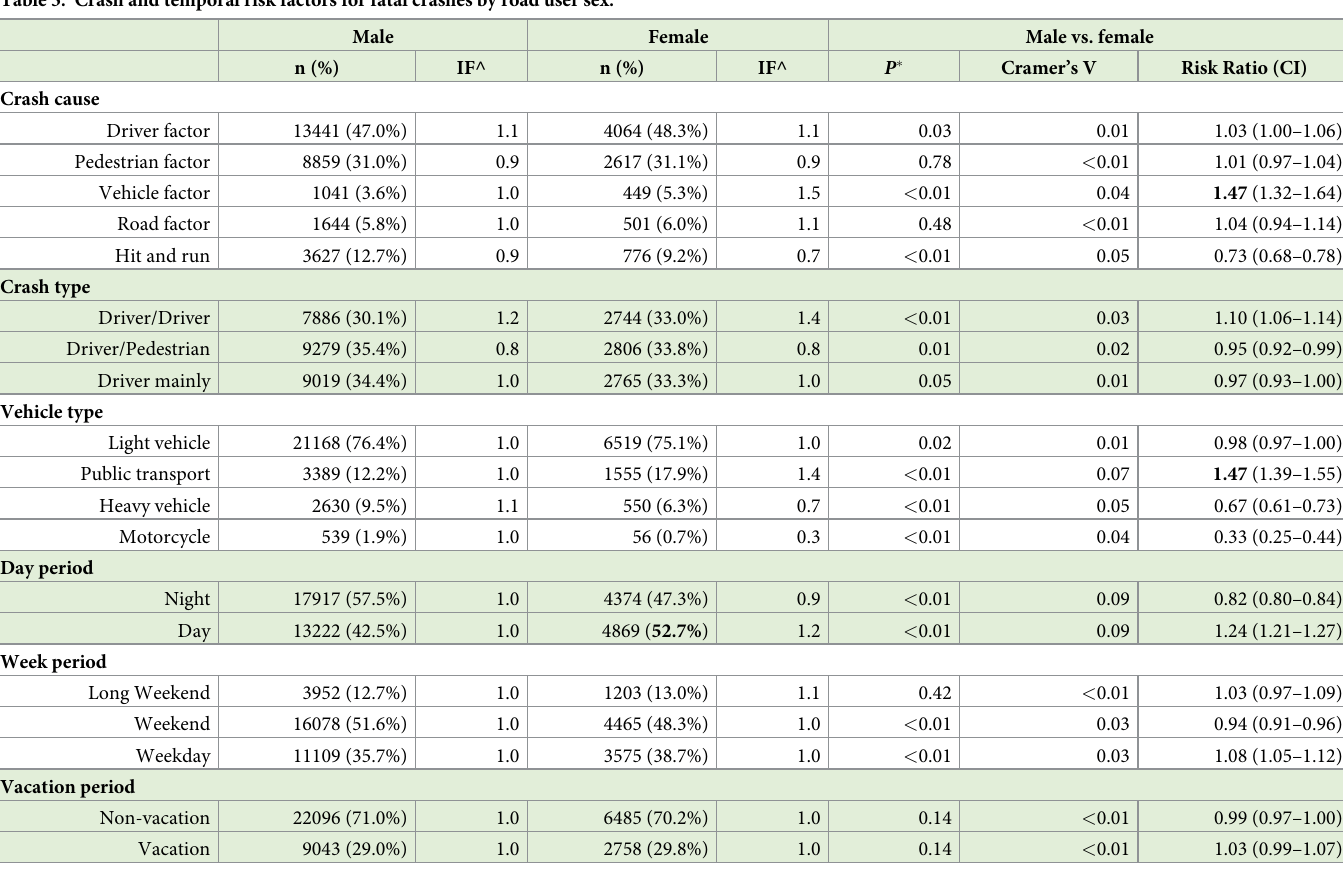
Table 3. Crash and temporal risk factors for fatal crashes by road user